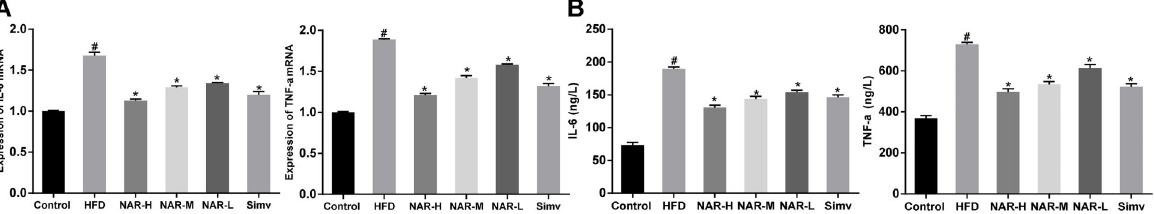
Figure 3. NAR decreased the in fl ammation in HFD-induced atherosclerosis ApoE – / – mice. A , mRNA expression of IL-6 and TNF- a detected using qRT-PCR; B , protein levels of IL-6 and TNF- a . Data are reported as mean ± SD. # P o 0.01, compared to the control group; *P o 0.05, compared to the HFD group; n=8 (ANOVA). NAR: naringenin: high (H), medium (M), low (L) detected with ELISA; HFD: high-fat-diet; ApoE – / – : apolipoprotein E-knockout; Simv: simvastatin; IL-6: interleukin-6; TNF- a : tumor necrosis factor- a .